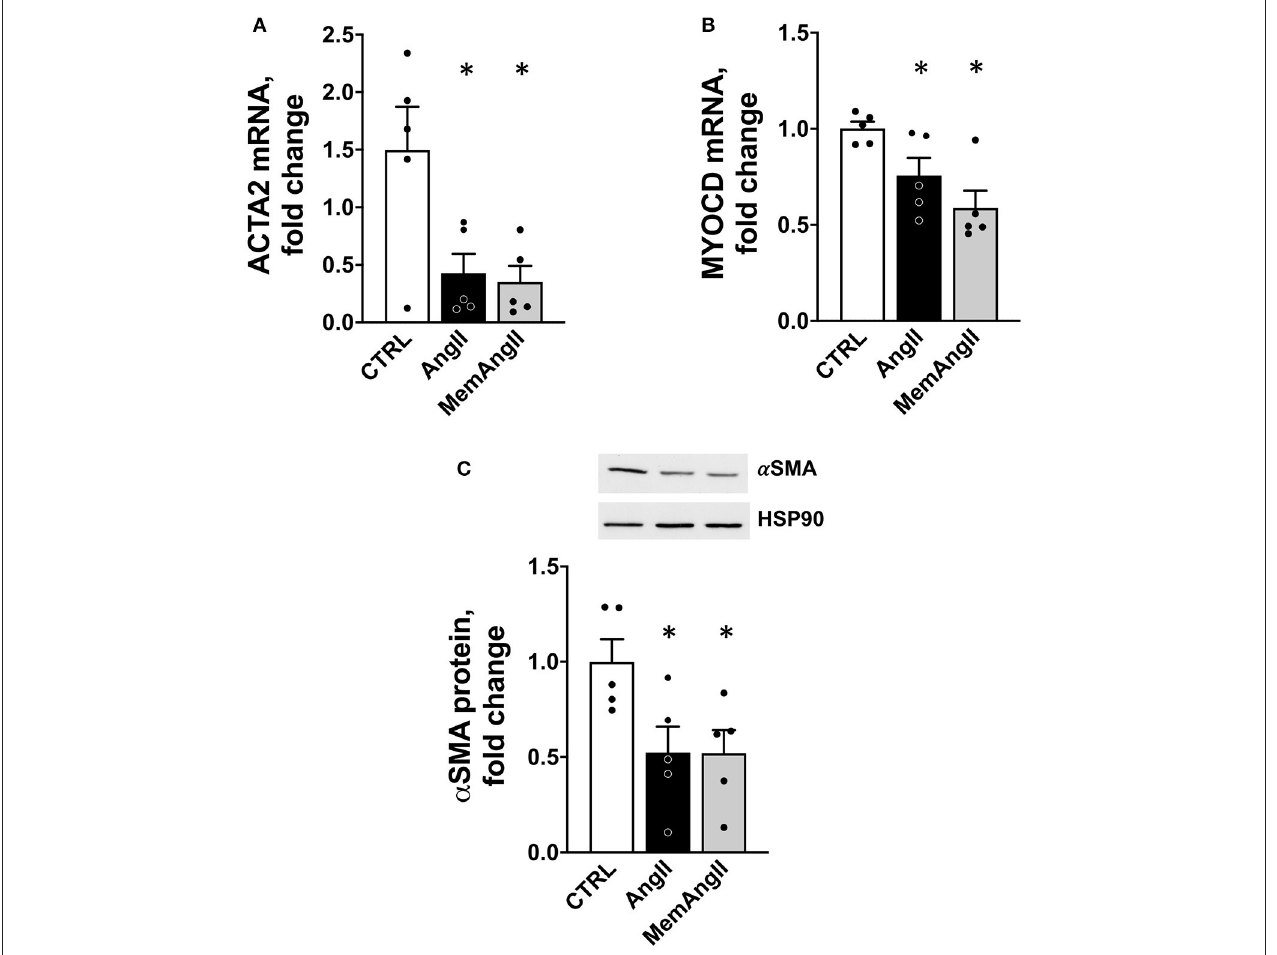
FIGURE 6 | Downregulation of ACTA2 and MYOCD in a homotypic cell culture model of human vascular smooth muscle cells reproducing the AngII “memory” effect in vitro . (A) ACTA2 mRNA expression (by RT qPCR) in HAVSMC exposed continuously ( AngII ) or transiently ( MemAngII ) to AngII compared with the control cells maintained in serum-deprived control media. (B) MYOCD mRNA expression in the same in vitro model (C) aSMA protein level in the same model, N = 5 independent experiments, * p < 0.05 one way ANOVA followed by Sidak’s multiple comparisons